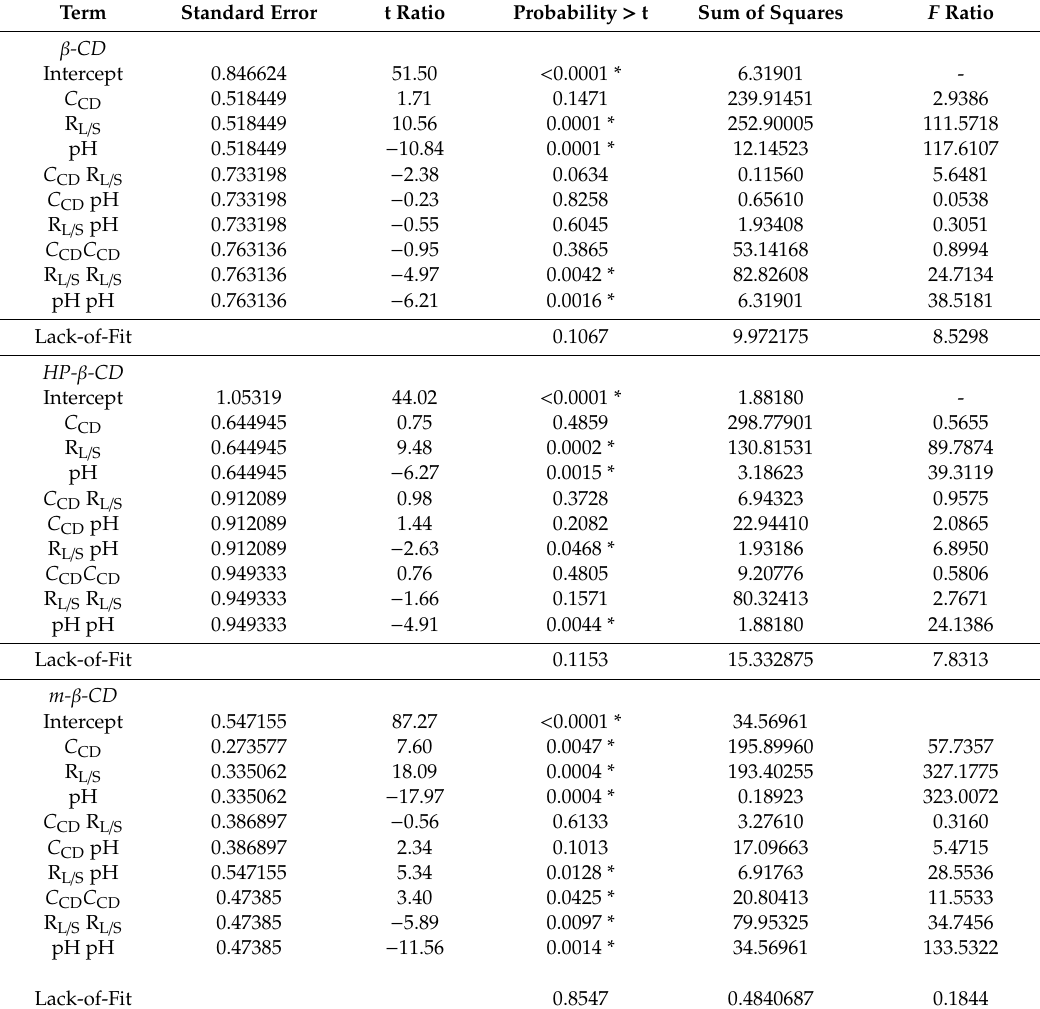
Table 2. Statistical data associated with the mathematical models, built using response